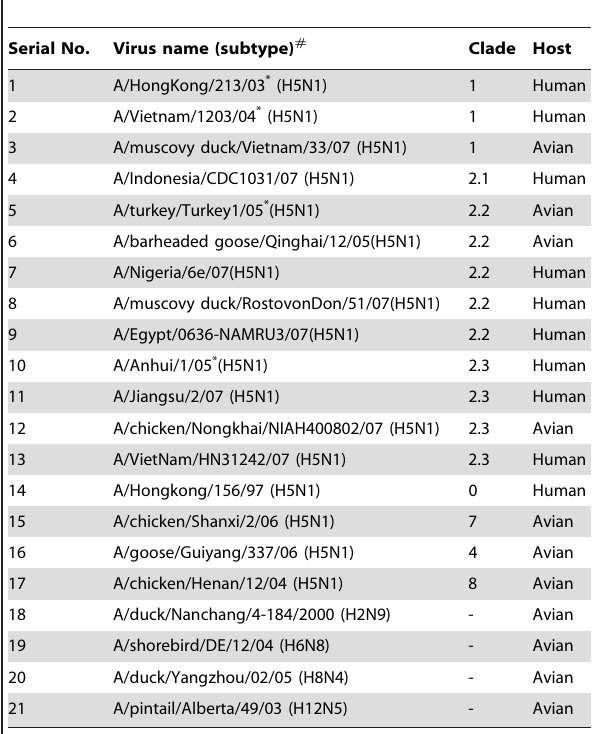
Table 2. Reassortant influenza A viruses generated by reverse